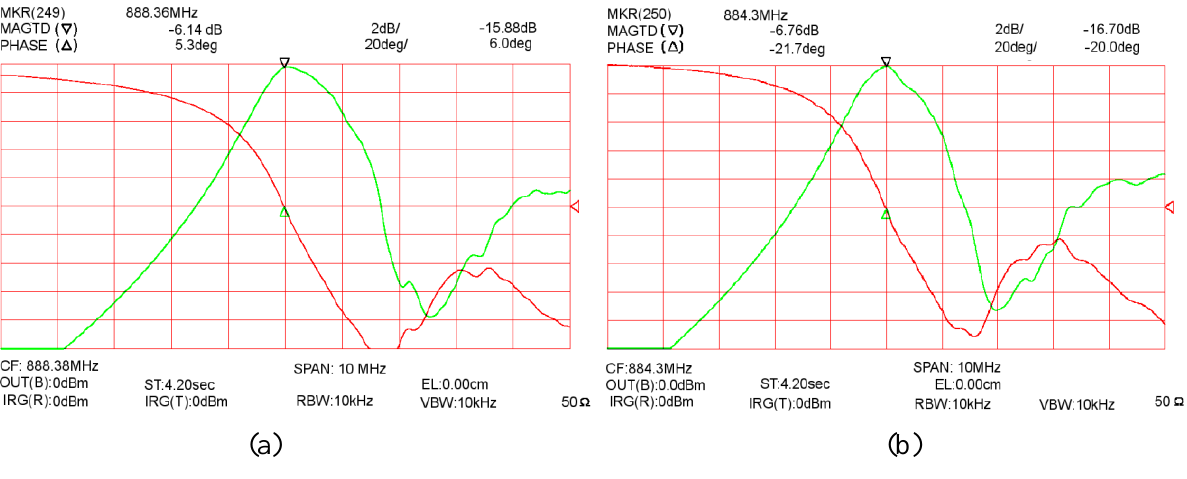
Figure 9. Narrowband frequency (upper curves) and phase (lower curves) characteristics of a 2-port FPAR measured ( a ) prior to layer deposition ( b ) after deposition of a 75 nm pp-HMDSO.